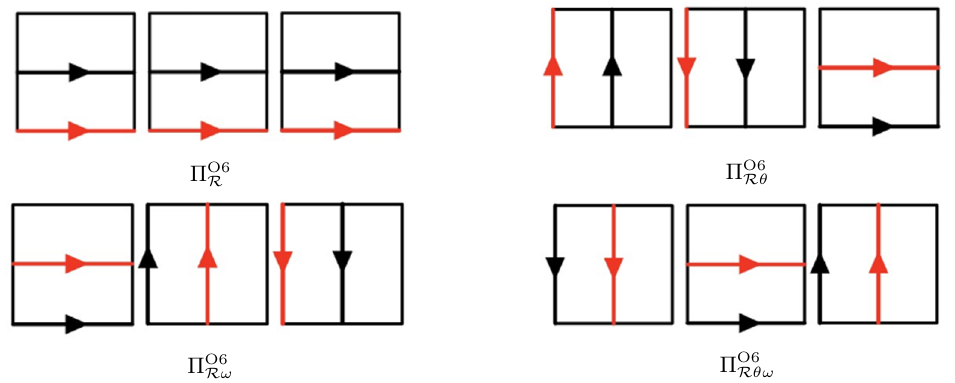
Figure 3. D6-brane configuration that leads to (3.21). In red are the O6-planes with D6-branes on top of